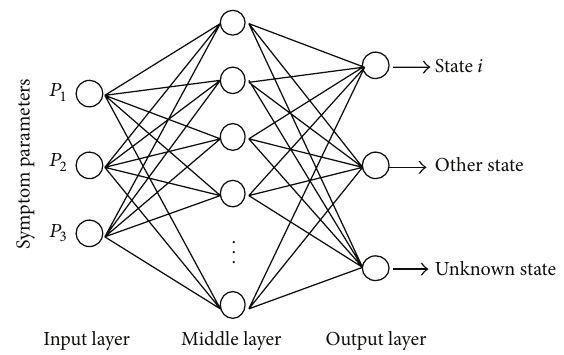
Figure 15: Sequential diagnosis method based on fuzzy neural